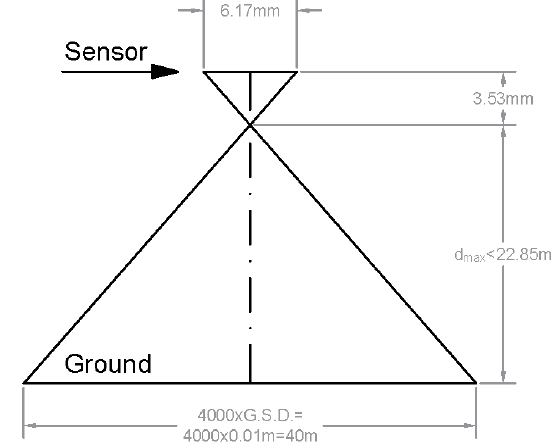
Figure 5. Limit distance value for each image acquisition with GSD=0.01m.